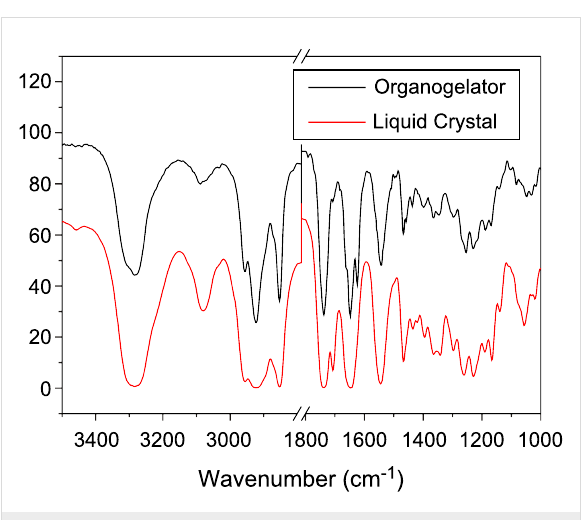
Figure 3: FT-IR of G3 as an organogelator and liquid crystal.